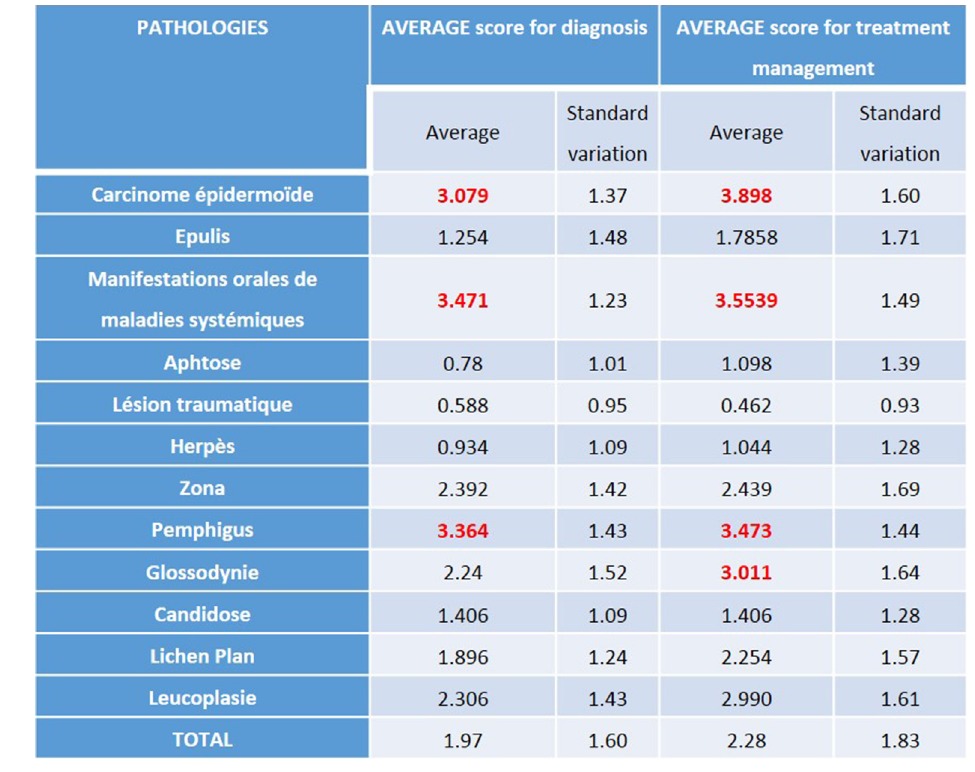
Table 1. Average score for diagnosis and treatment for each